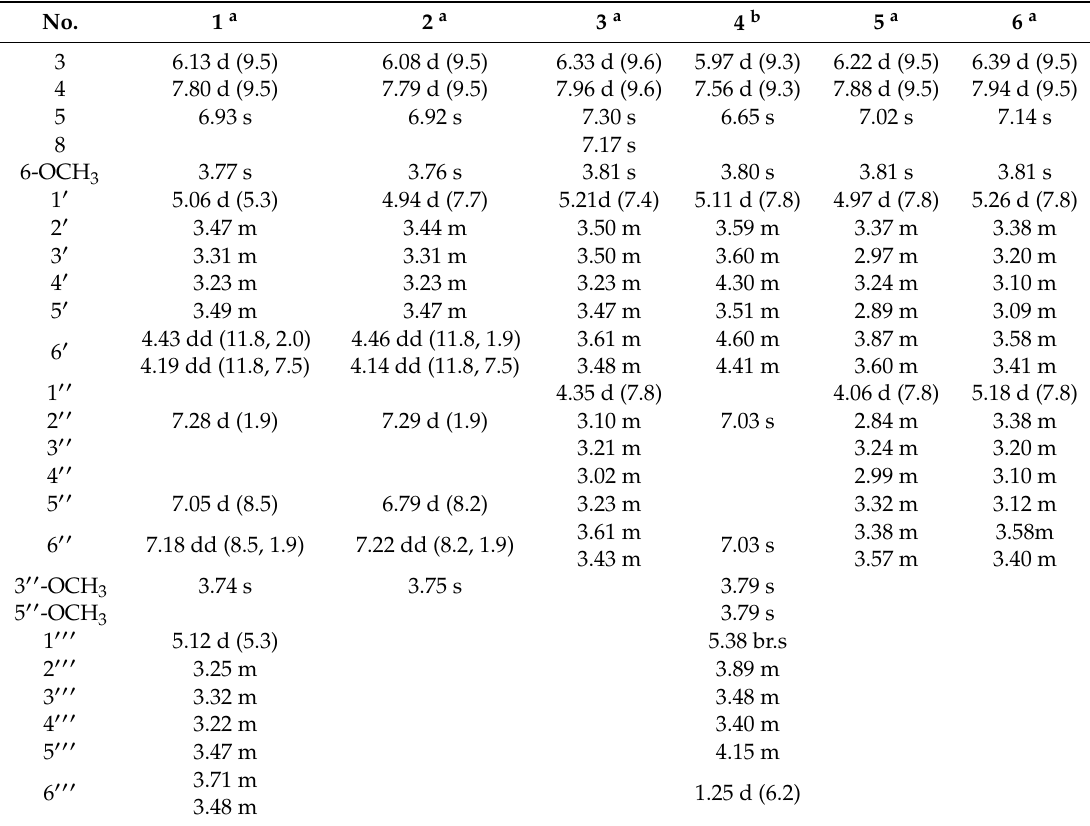
Table 1. 1 H NMR spectroscopic data (500 MHz) of 1 – 6